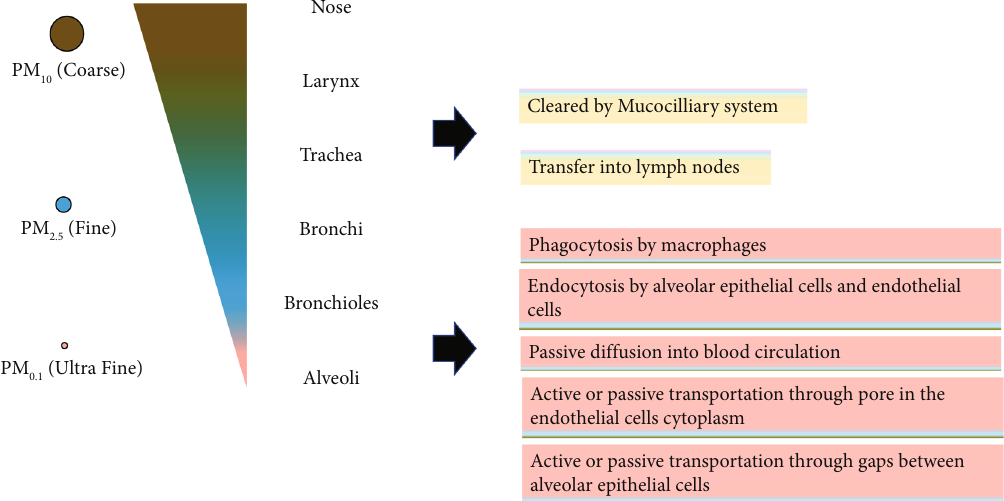
Figure 2: PM deposition along the airway. Coarse particles (PM ) and fi ne particles are deposited more on upper airways, cleared by the 10 mucociliary system, and transferred into lymph nodes. Ultra- fi ne particles can reach alveoli, and enter blood circulation through several mechanism including phagocytosis by macrophages, endocytosis by alveolar epithelial cells and endothelial cells, passive di ff usion into blood circulation, active or passive transportation through pore in cytoplasm of endothelial cells, and gaps between epithelial